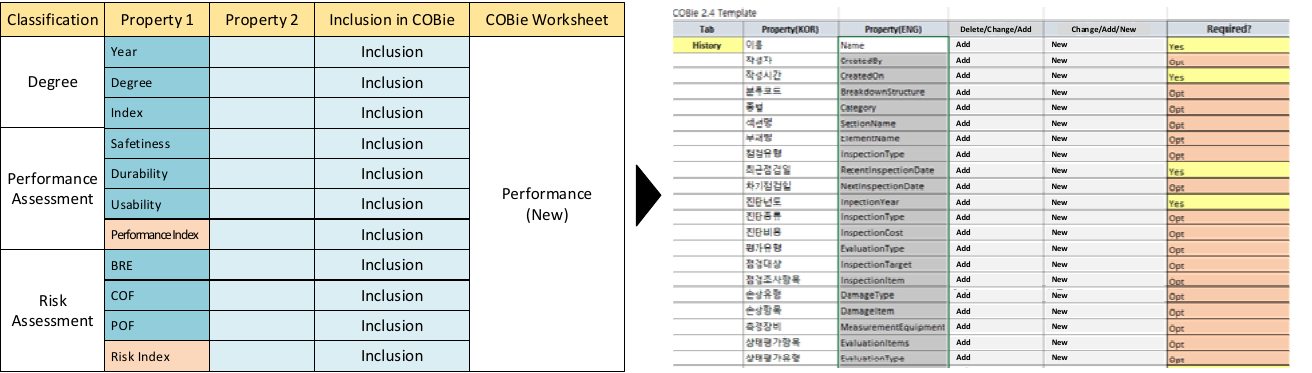
Figure 6. Determining COBie components—categorization.